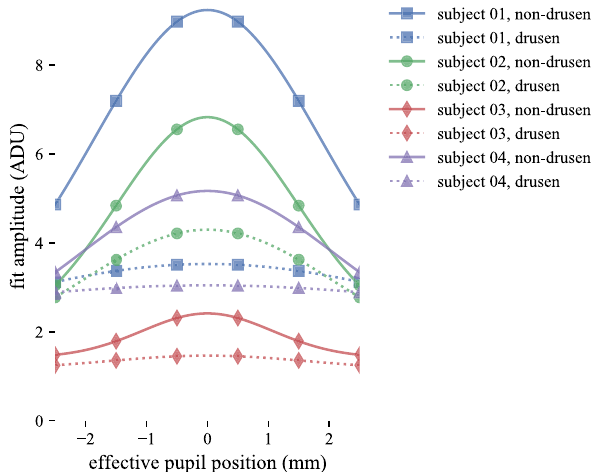
Figure 7. Gaussian models of non-drusen and drusen IS/OS amplitude in all subjects. For each of the four subjects, the Gaussian fits to IS/OS amplitude from non-drusen (blue) and drusen (green) zones are plotted separately. In all four subjects, IS/OS amplitude a I varied more with effective pupil position x in the non-drusen zone than in the drusen zone, suggesting that the optical properties of the photoreceptors in the two zones were different. If the primary cause for reduced visibility of drusen-affected photoreceptors was only disorientation (i.e., pointing away from the pupil), the non-drusen and drusen models would appear similar.